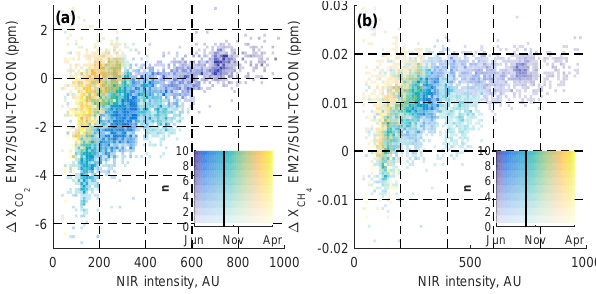
Figure 5. (a) The X CO retrieved from the EM27/SUN compared to 2 TCCON decreased with signal intensity for the first set of mirrors. In October the mirrors were changed, which caused the retrieved X CO to increase. The inset is the legend for the average date and 2 Figure 6. Top row: averaging kernels from the Caltech EM27/SUN retrieved from the number of points in the histogram bins. (b) X CH 4 instrument. Bottom row: averaging kernels from the EM27/SUN compared with TCCON.